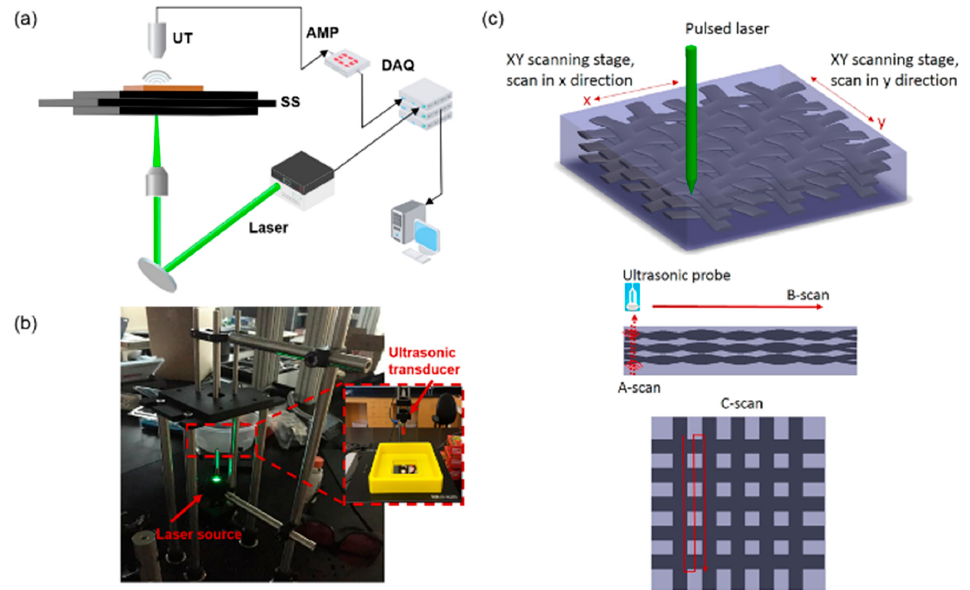
Figure 1. Developed photoacoustic non-destructive evaluation (pNDE) system. ( a ) A schematic of the pNDE system, showing the following key components: UT, ultrasonic transducer; SS, scanning stage; OL, objective lens; AMP, amplifiers; DAQ, data acquisition card; Laser, green laser (532